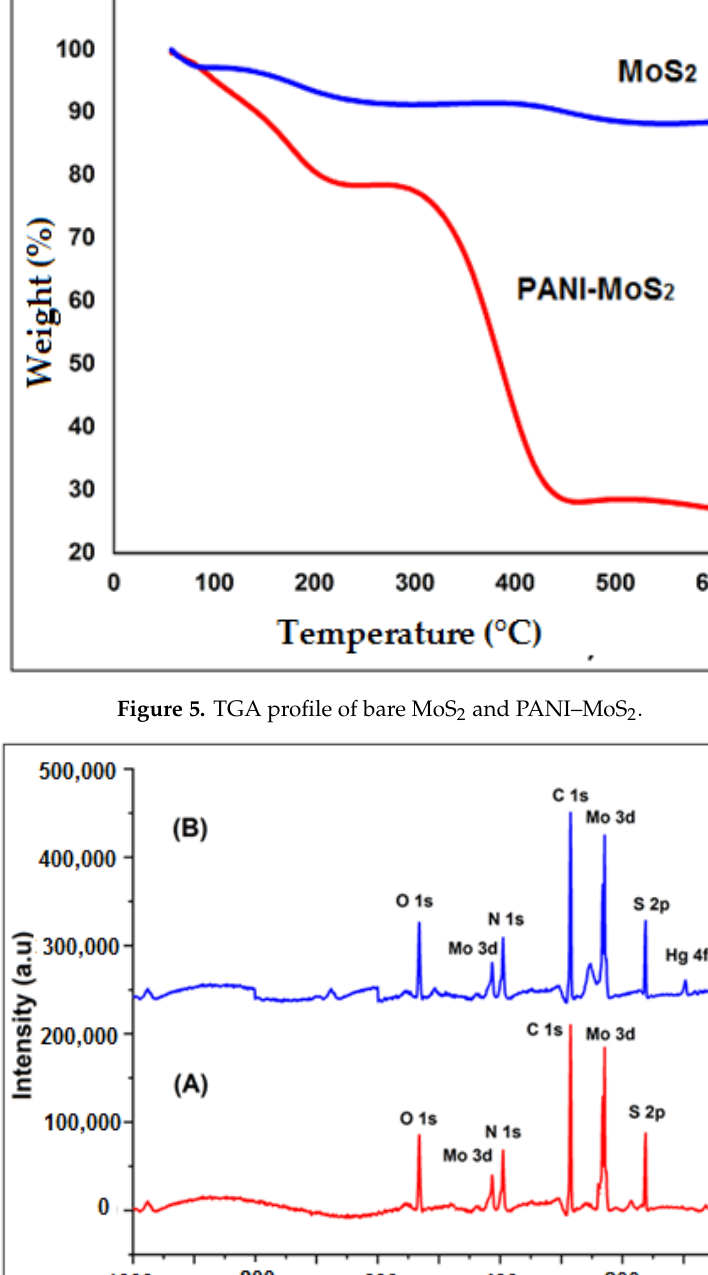
Figure 4. Nitrogen adsorption isotherm of PANI–MoS 2 adsorbent.